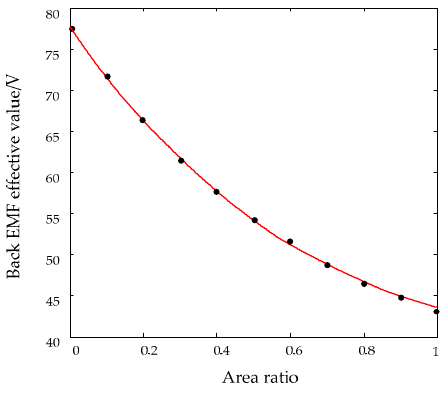
Figure 6. The curve of back EMF effective value in no-load condition.